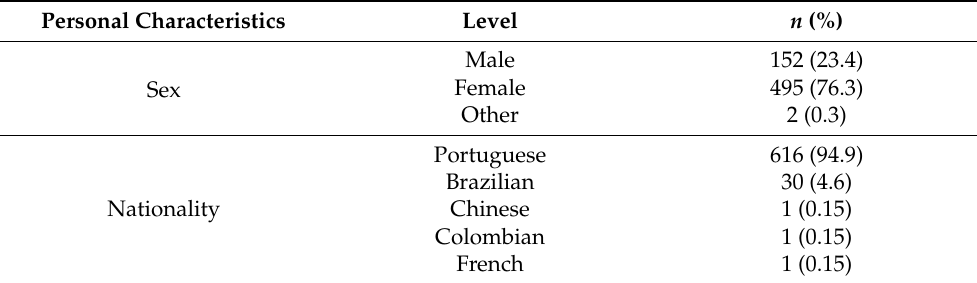
Table A1. Socio-demographic variables. Results are shown in absolute and relative (%)